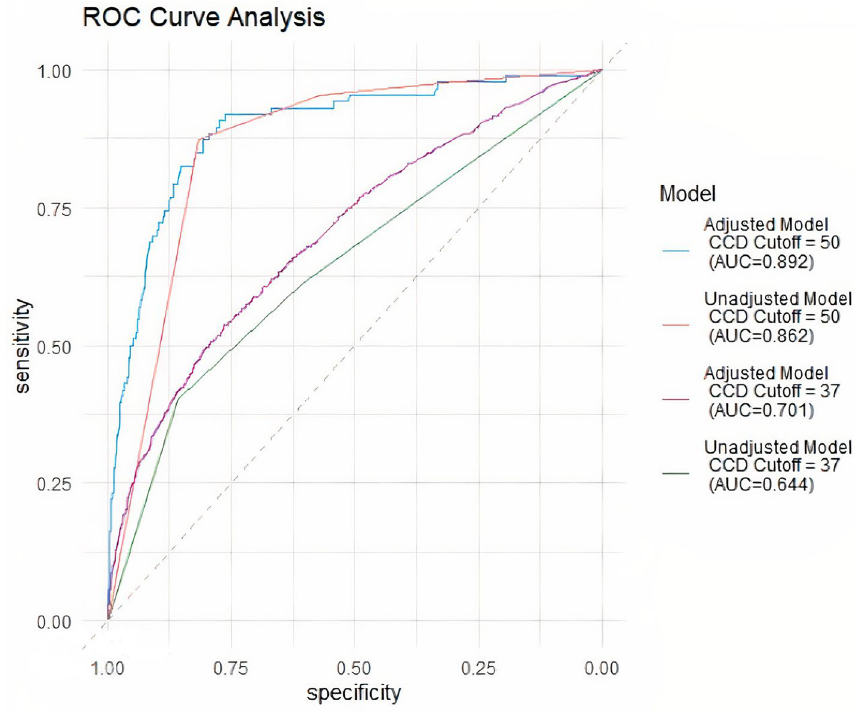
Figure 3. ROC curve generated from predictive models relating selected dog characteristics to Canine Cognitive Dysfunction prevalence, Dog Aging Project